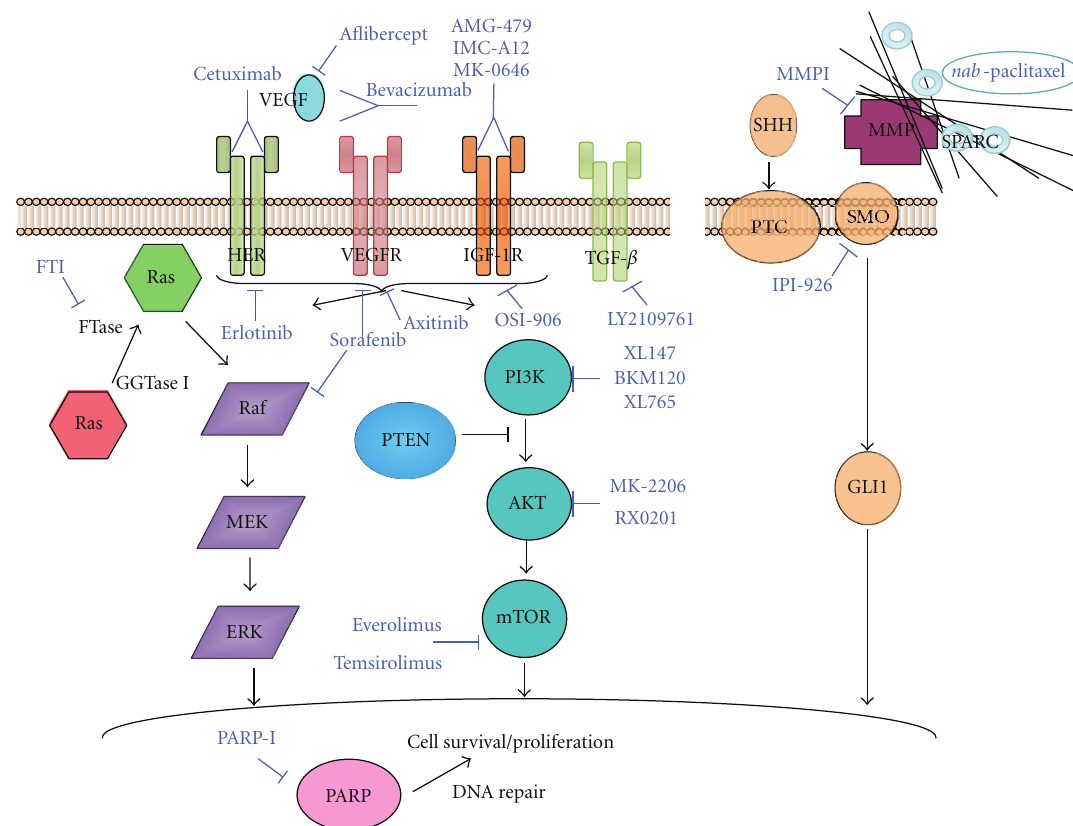
Figure 1: Selected signaling pathways and their targeting in advanced pancreatic